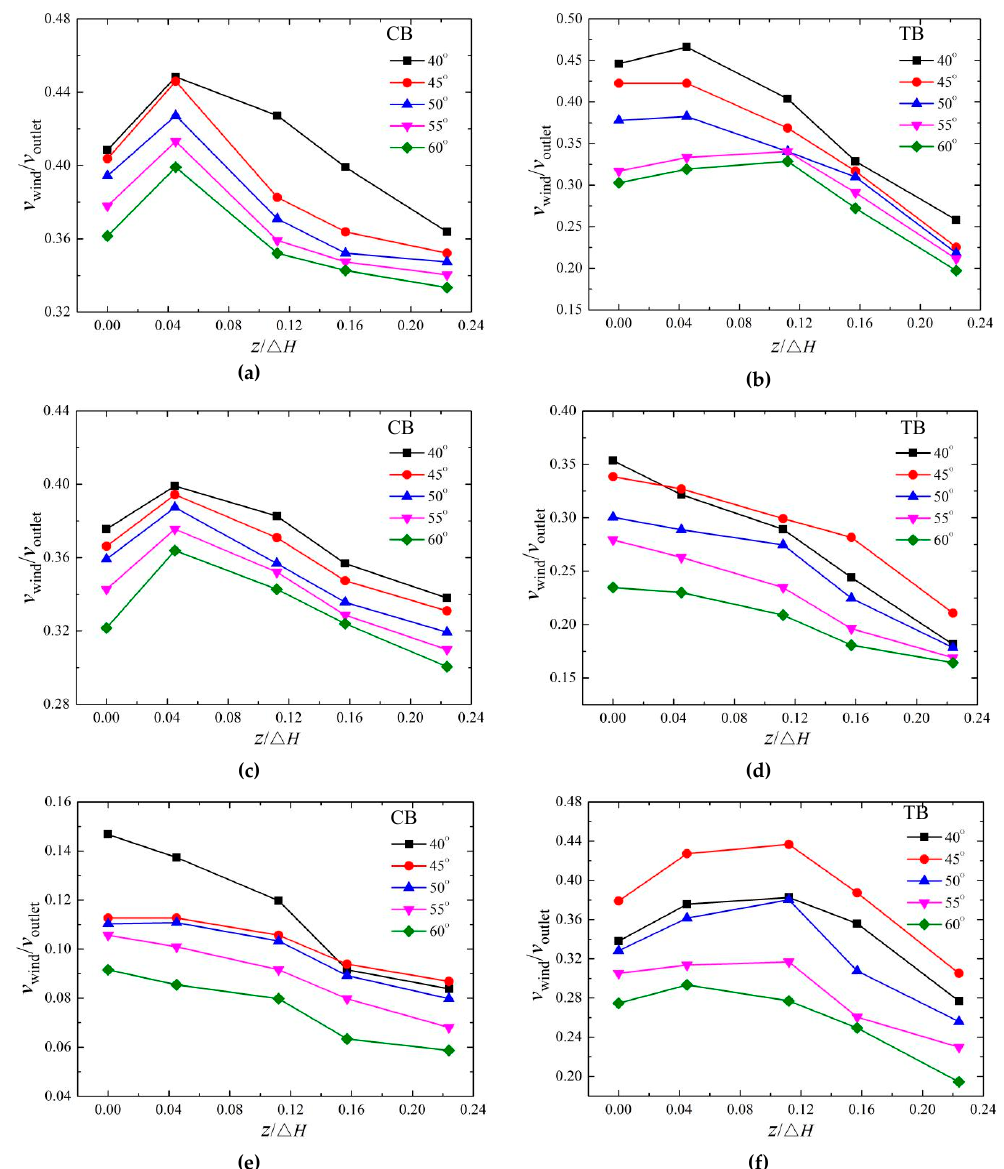
Figure 11. The wind velocity of the vertical distribution at different bucket angles: (a) CB (2.37, 0), (b) TB (2.37, 0), (c) CB (2.60, 0), (d) TB (2.60, 0), (e) CB (3.04, 0.448), and (f) TB (3.04, 0.448).